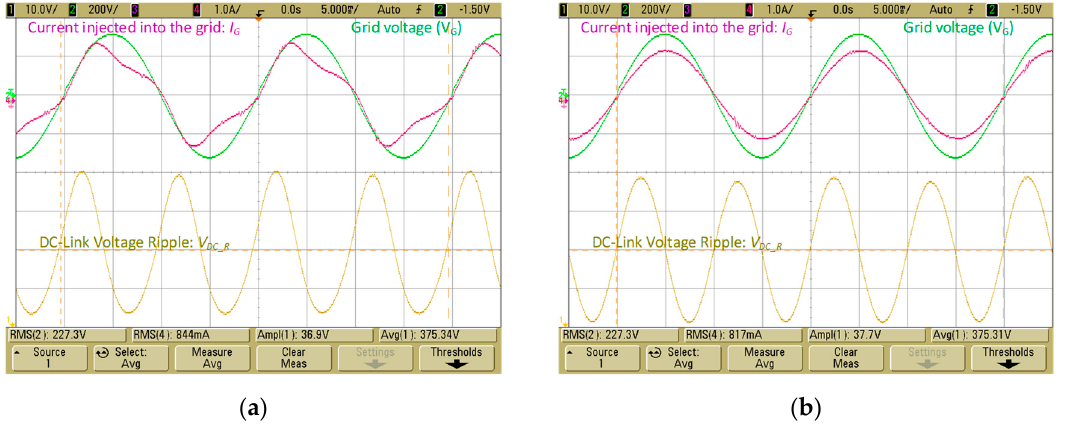
Figure 13. THDi of the current injected into the grid at P G = 200 W. Grid: EN-61000-4-7 (1.2% THDv). Fc_ VDC = 50 Hz. ( a ): PI Reg.: Gv DC (s). ( b ): PI Reg. + Notch filter: Gv DC (s) + F NS (s).